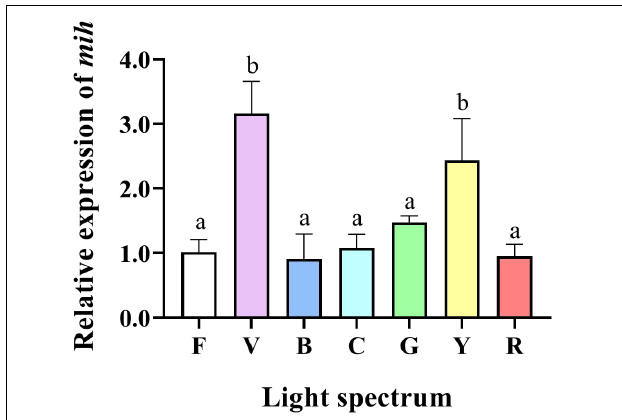
FIGURE 7 | Gene expression of molt-inhibiting hormone ( mih ) gene in the eyestalk of S. paramamosain reared under the various light spectrum. Values are expressed as means ± SD ( n = 3, 2 individuals per replicate). F, Full spectrum; V, Violet; B, Blue; C, Cyan; G, Green; Y, Yellow; R, Red. Different superscripts denote significant differences between treatments ( P < 0.05).